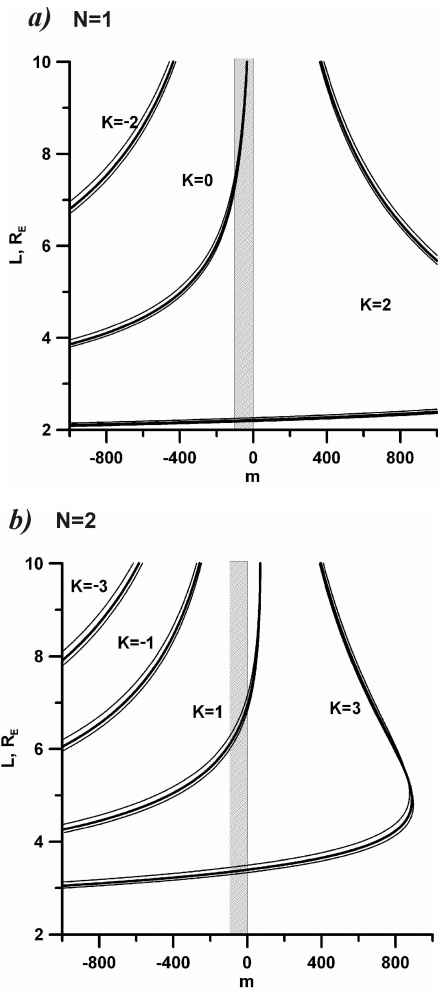
Fig. 2. Location of regions of the most effective instability in L - m plane for various K and (cid:15) ∼ 10 keV : a) N = 1 case, b) N = 2 case. Thick solid lines correspond to the growth rate maximum location, thin lines correspond to an e -times smaller growth rate than its maximal value. The shaded region corresponds to the observed values of azimuthal wave numbers − 100 < m < 0 . Fig. 3. Location of regions of the most effective instability in L - m plane for various K and (cid:15) ∼ 150 keV : a) N = 1 case, b) N = 2 case. Thick solid lines correspond to the growth rate maximum location, thin lines correspond to an e -times smaller growth rate than its maximal value. The shaded region corresponds to the observed values of azimuthal wave numbers − 100 < m < 0 .